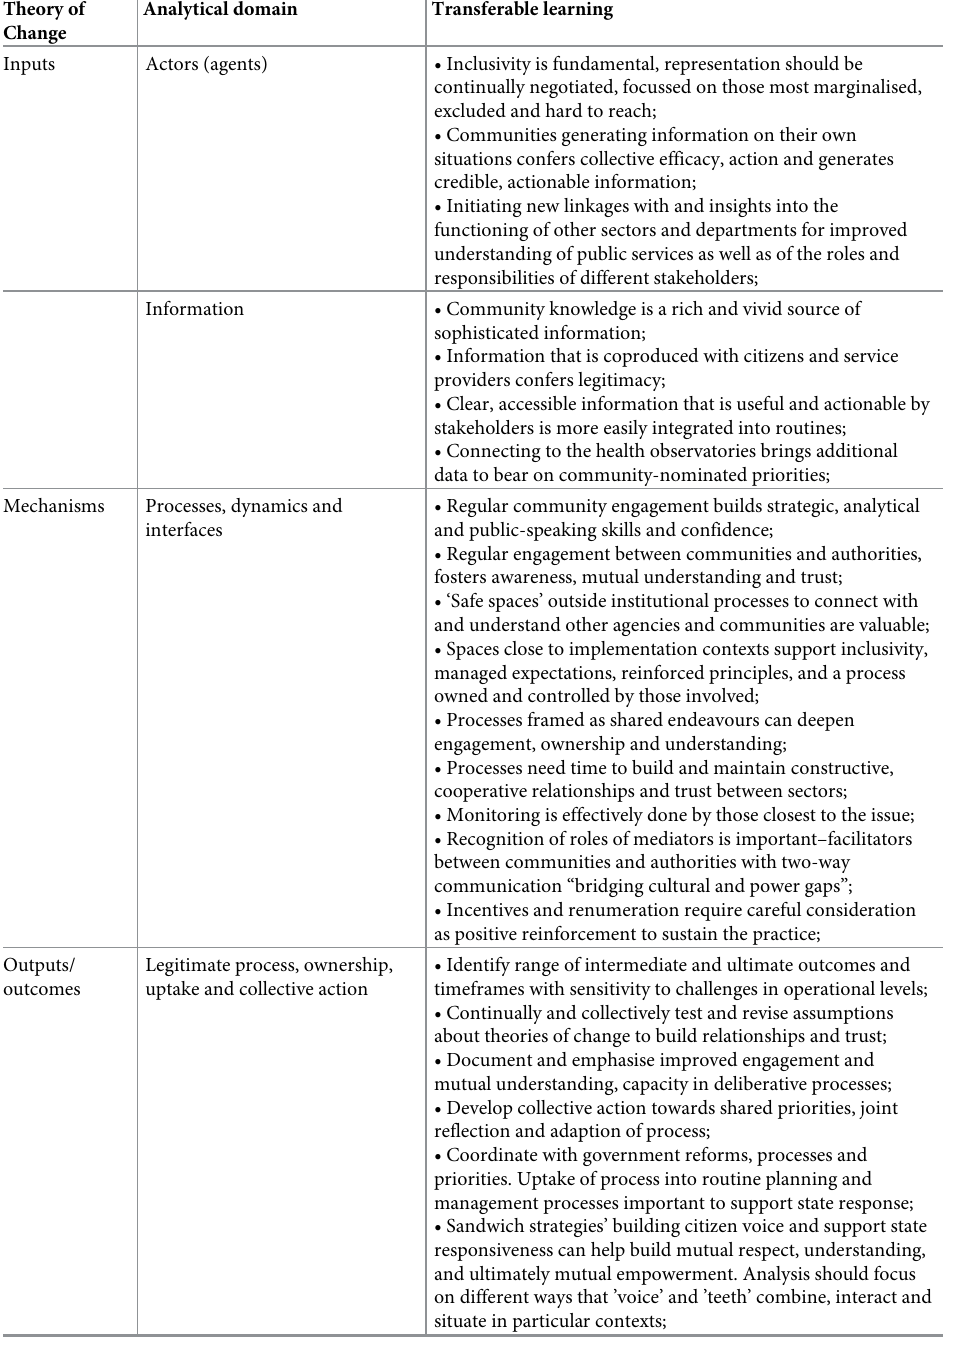
Table 3. Transferable learning on community-led multisectoral action